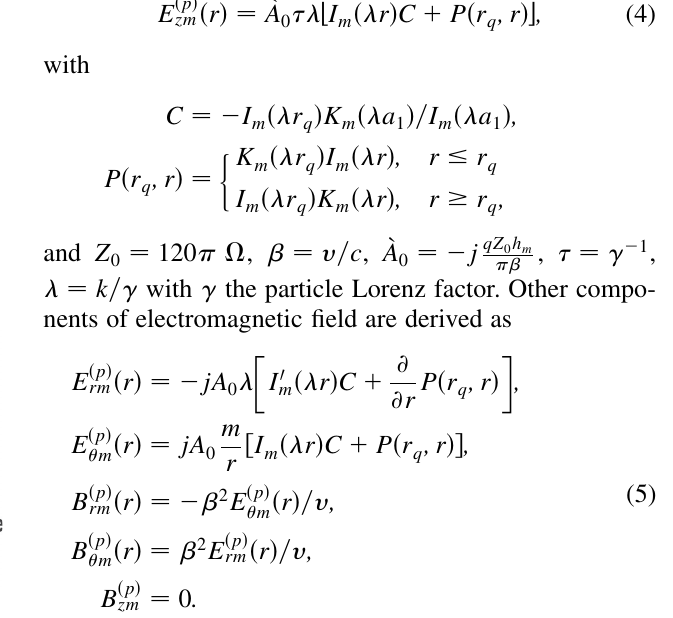
FIG. 1. Geometry of the laminated vacuum chamber. The pointlike charge is moving with arbitrary constant velocity along the tube